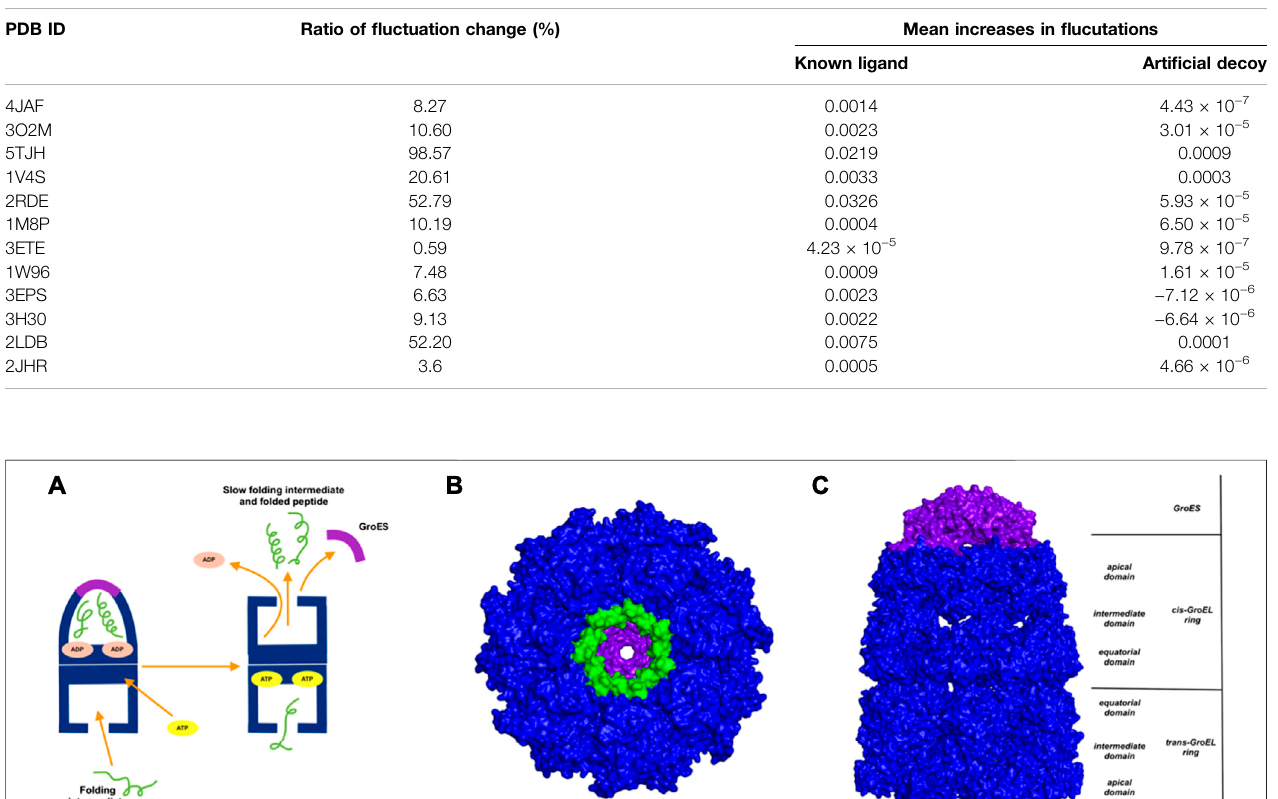
TABLE2| Ratiosofincreasesin fl uctuationstodecreasedin fl uctuationsuponligandbinding,meanincreasesin fl uctuationsintheresidueswhere fl uctuationincreasesupon ligand binding, and mean decrease in fl uctuation in the residues where fl uctuation decreases upon ligand binding.